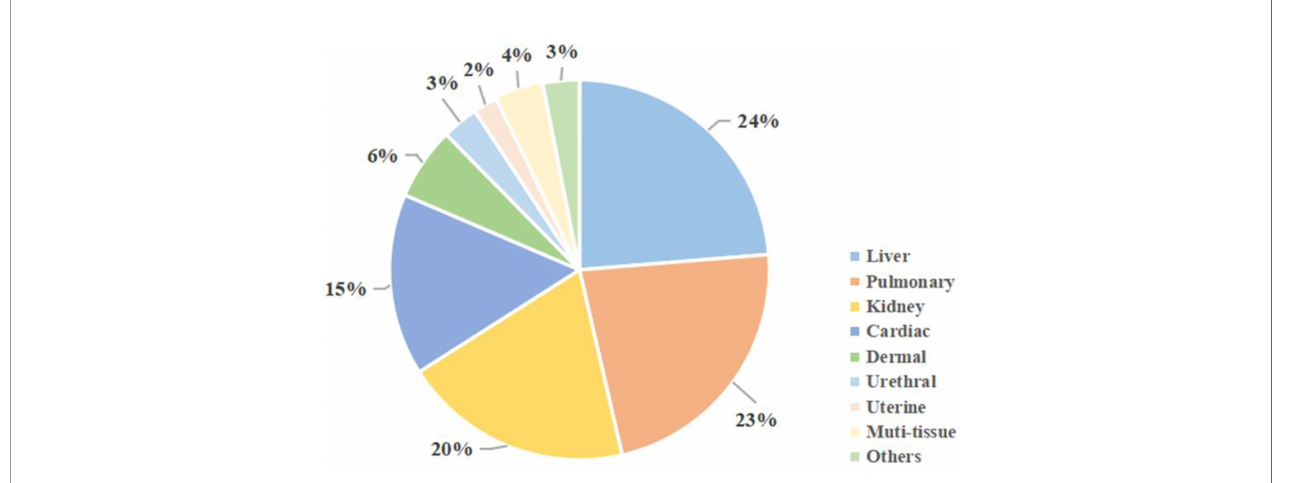
FIGURE 4 | MSCs studies on different tissue fi brosis in recent 5 years. Using the keywords “ fi brosis ” and “ mesenchymal stem cells ” , as well as speci fi c organs, a search was conducted on the PubMed online library. Results were restricted to studies published from 2017 to